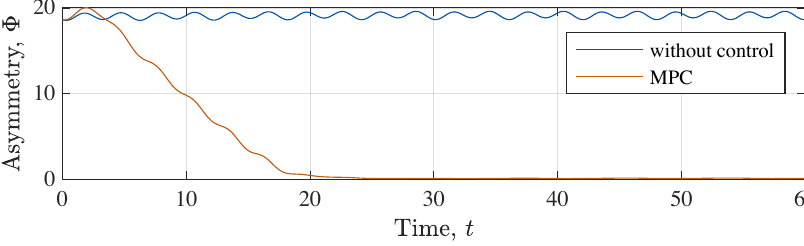
Figure 4. History of the asymmetric function. (Blue line: Without control, Red line: With MPC).